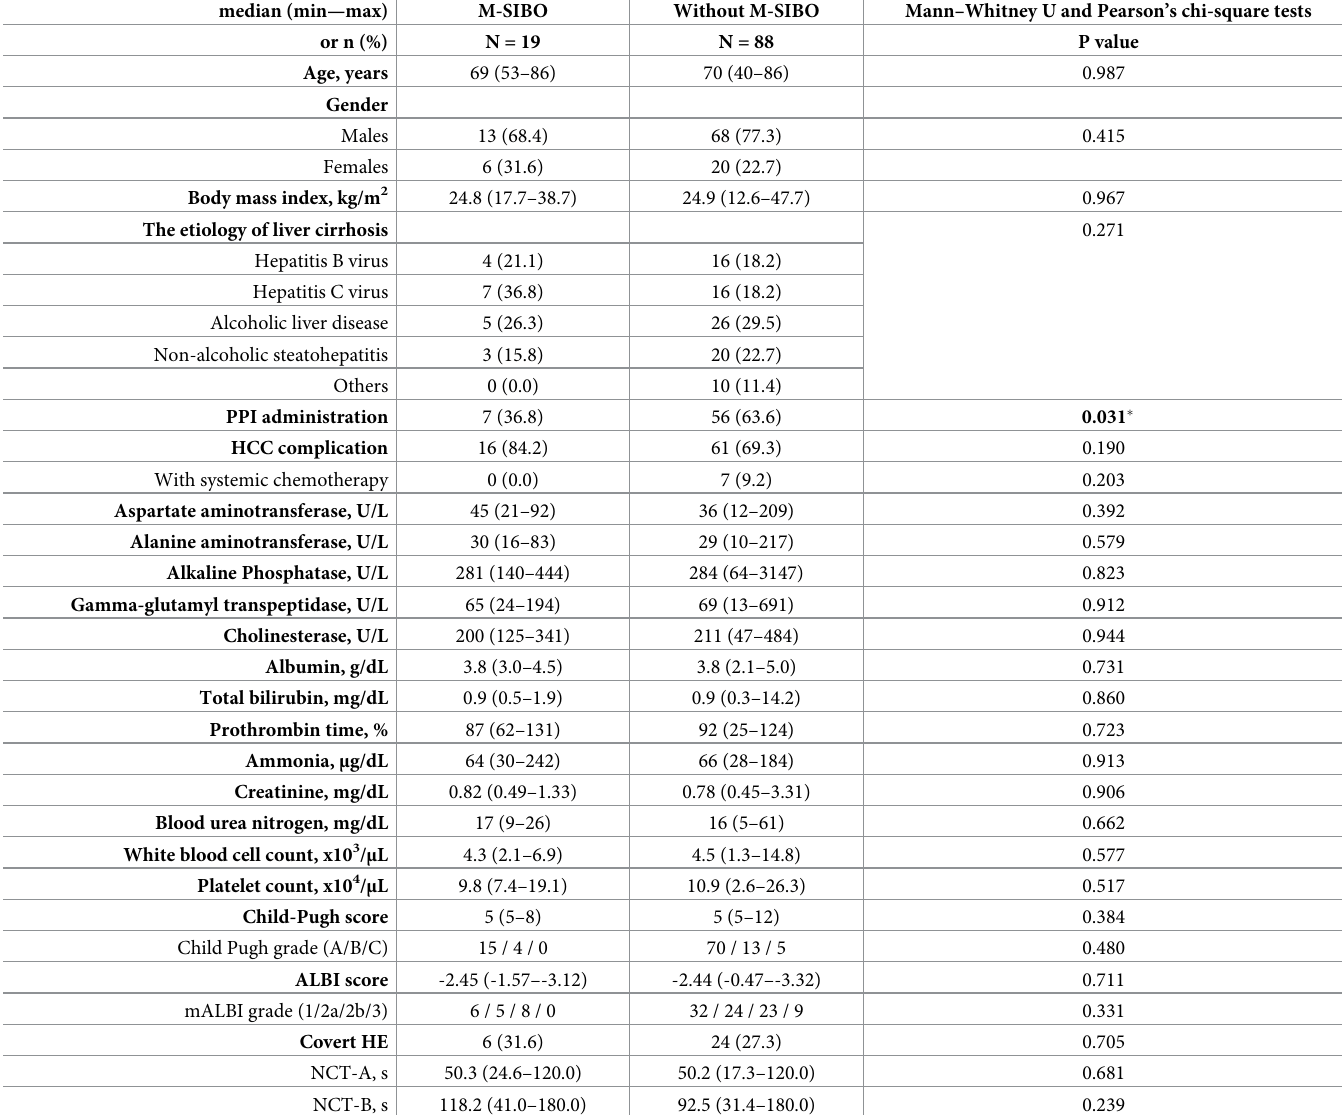
Table 4. Non-parametric tests clustered by M-SIBO /